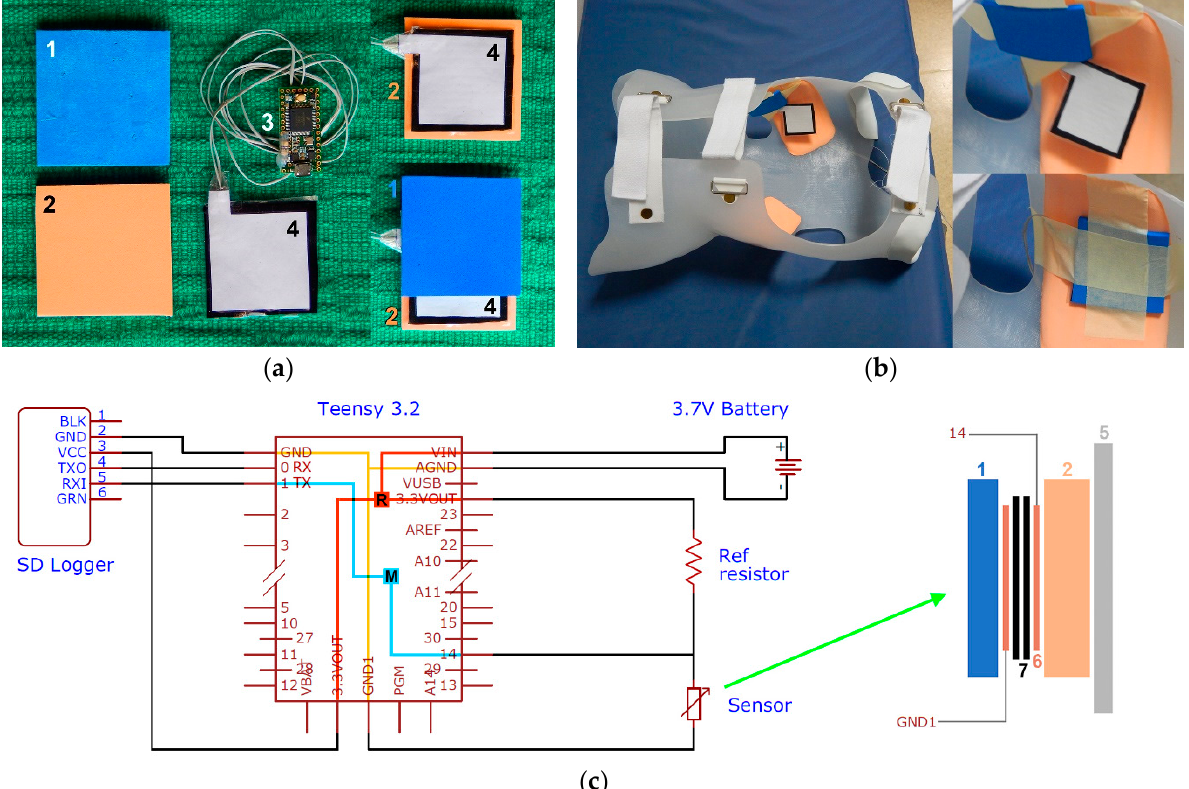
Figure 1. ( a ) Sensor system: 1st column: 1: softer foam (blue); 2: denser foam (pink); 2nd column: 3: Teensy and microcontroller; 4: sensor (black: piezoresistive polymer, white: backside of a copper electrode); 3rd column: assembly process: sensor 4 placed on denser pink foam 2, and softer blue foam 1 placed on sensor 4 (in the final assembly, both foams are superimposed); ( b ) sensor placed inside a Chêneau brace and taped to the inner wall of the brace; ( c ) circuit and electronics diagram, and sensor cross section; R: regulator (3.7 V (VIN) to 3.3 V (3.3VOUT)); M: microcontroller (analog drop voltage signal from port 14 converted to digital ASCII data recorded by the SD logger (Secure Digital memory card)); 5: hard shell of brace; 6: copper electrode; 7: piezoresistive sensor (two layers); GND: ground; TX, RX: transmitting and receiving ports.